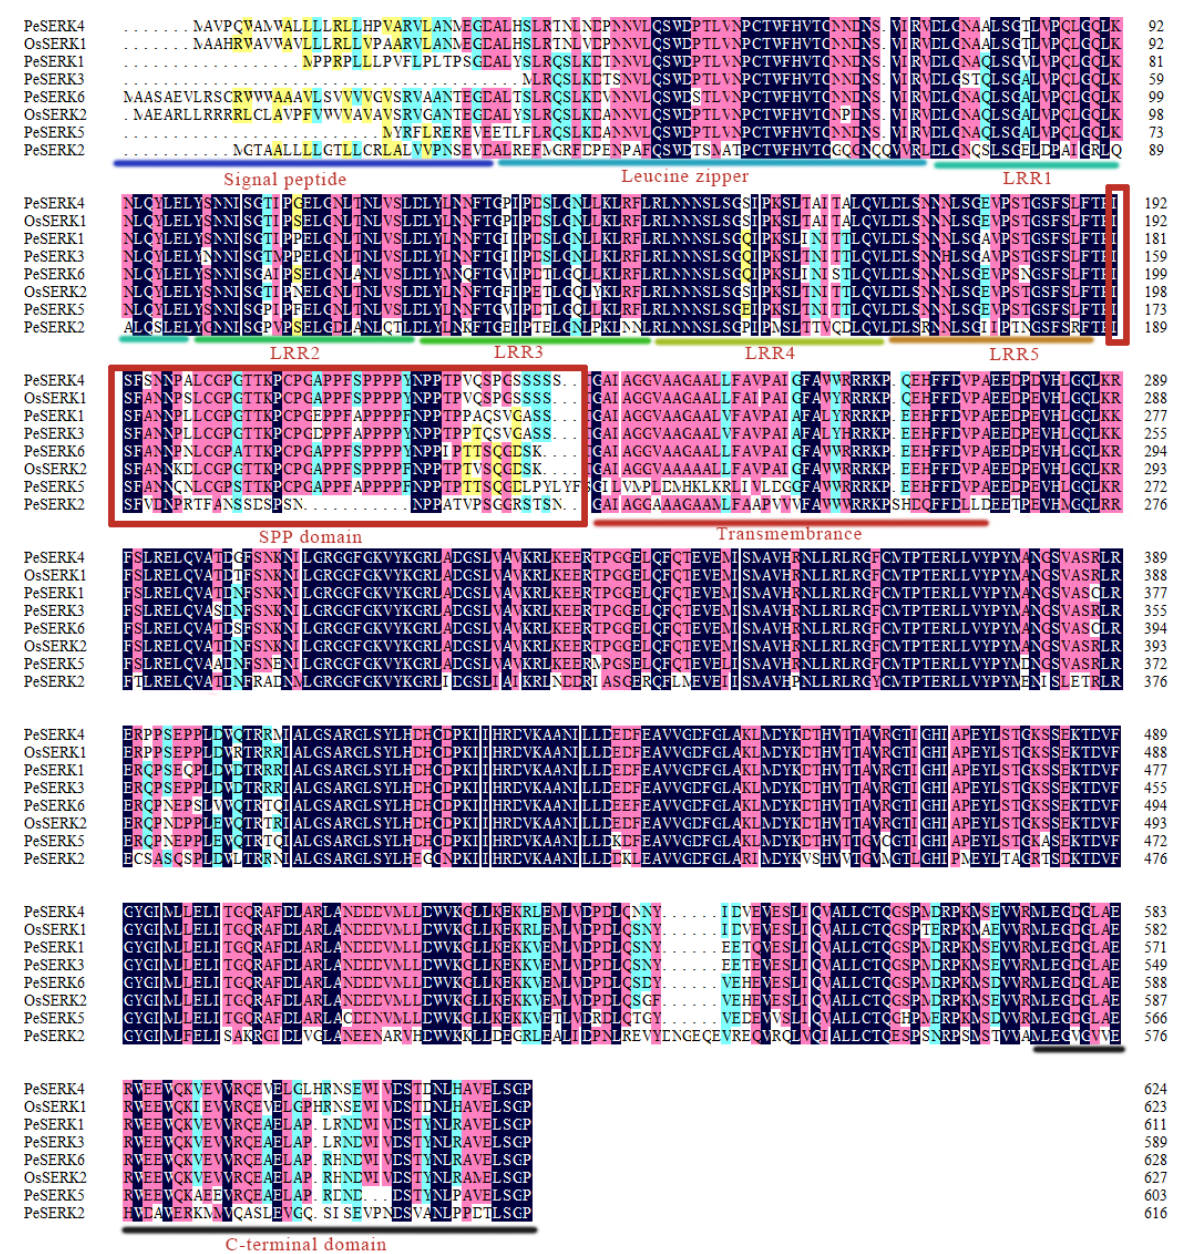
Figure 1. Comparison of SERKs in moso bamboo and rice. The signal receptor domain, transmem- brane domain, intracellular kinase activity domain, SPP-motif and C-terminal domain are under- lined.